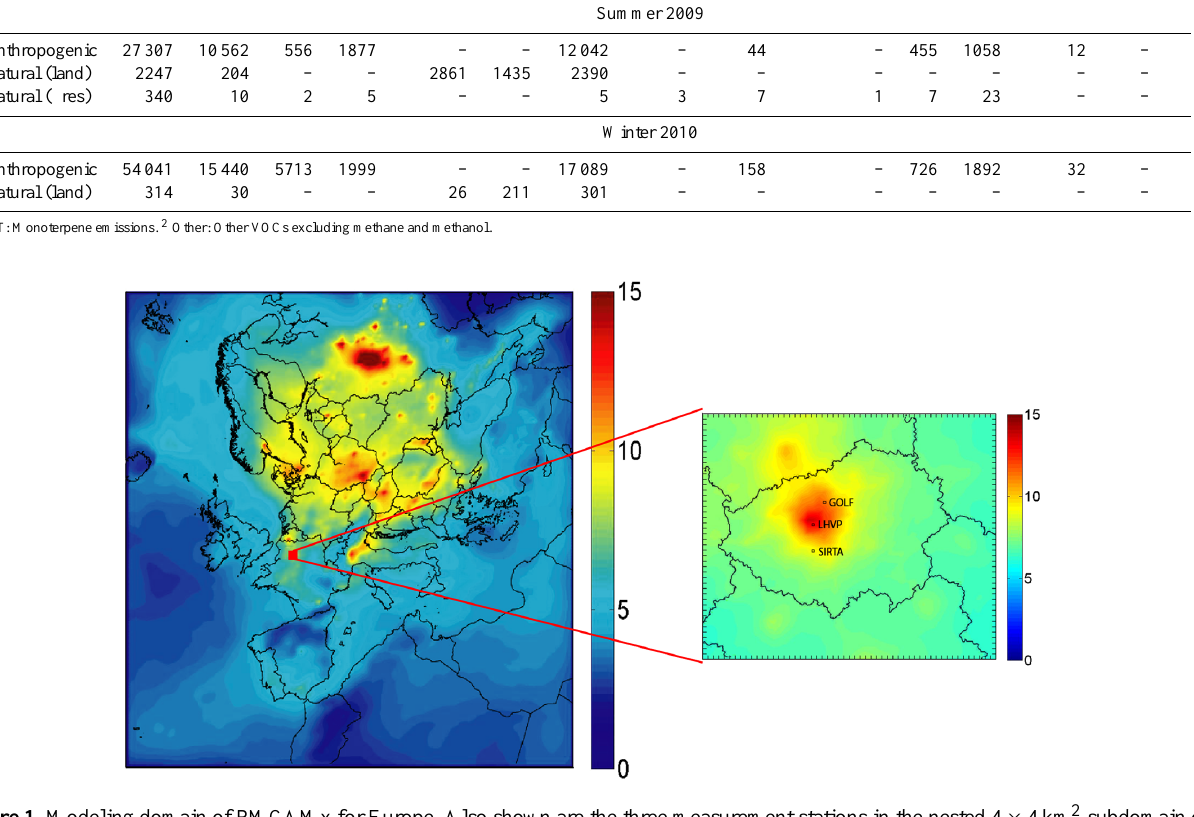
Figure 1. Modeling domain of PMCAMx for Europe. Also shown are the three measurement stations in the nested 4 × 4km 2 subdomain of Paris. Color coding shows the predicted average ground concentrations (in µgm − 3 ) of PM 1 during winter